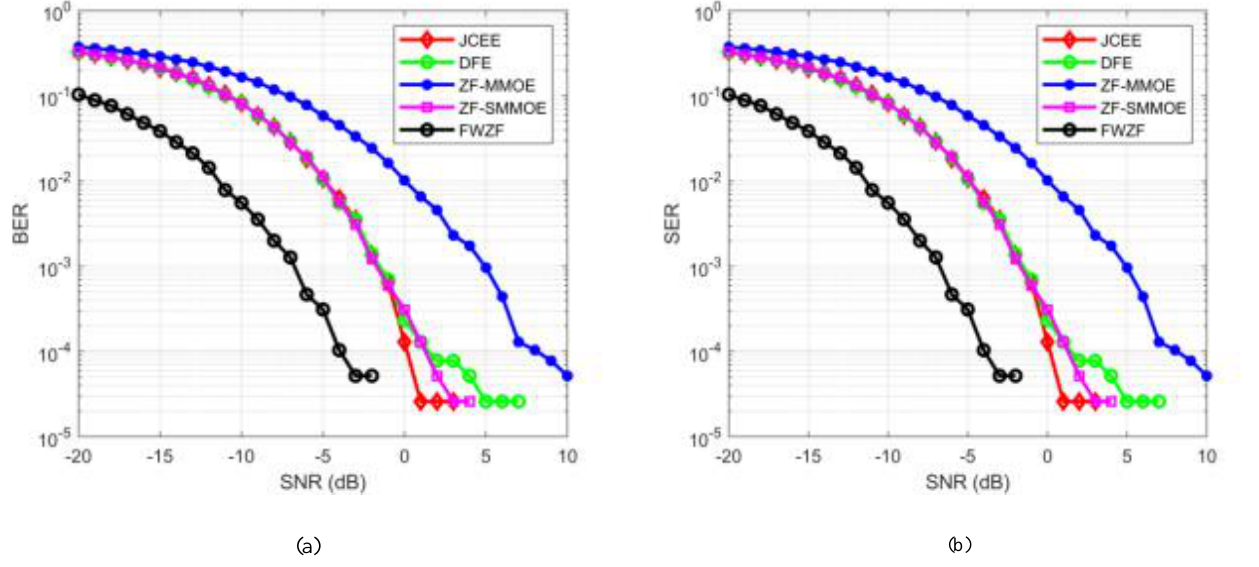
Fig. 7. Comparative analysis using antenna=6 in Rician channel, (a) BER, (b)